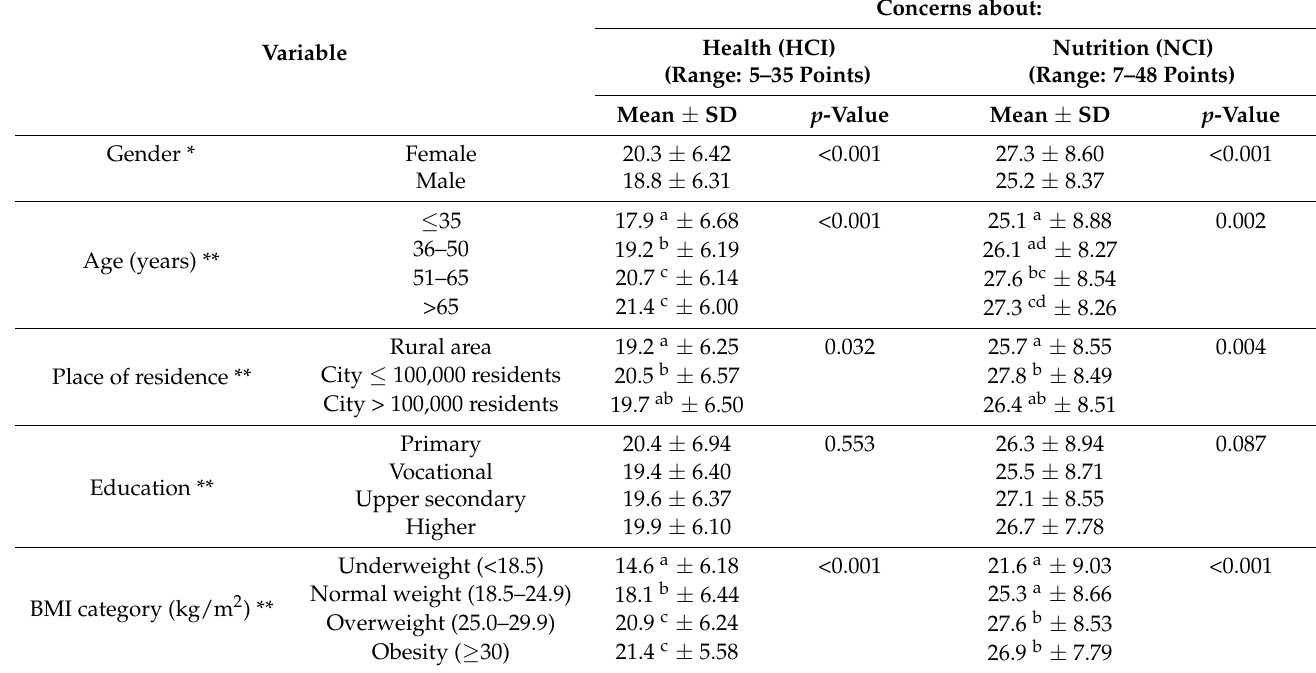
Table 4. Perceived health and nutrition concerns in the study sample ( N =